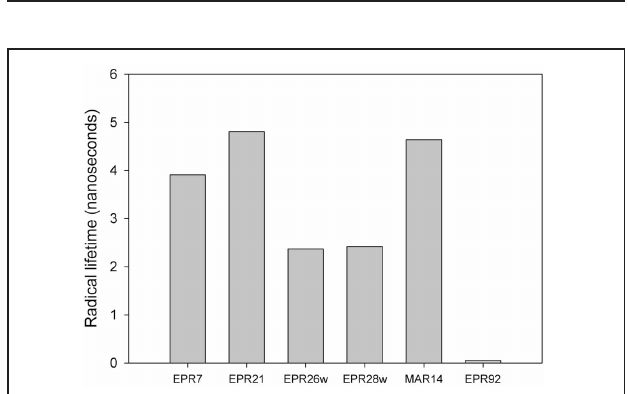
FIGURE 4 | Measured radical lifetimes for hydrothermal vent isolates EPR7, EPR21, EPR26w, EPR28w, MAR14, and EPR 92 using norcarane as the radical clock substrate.